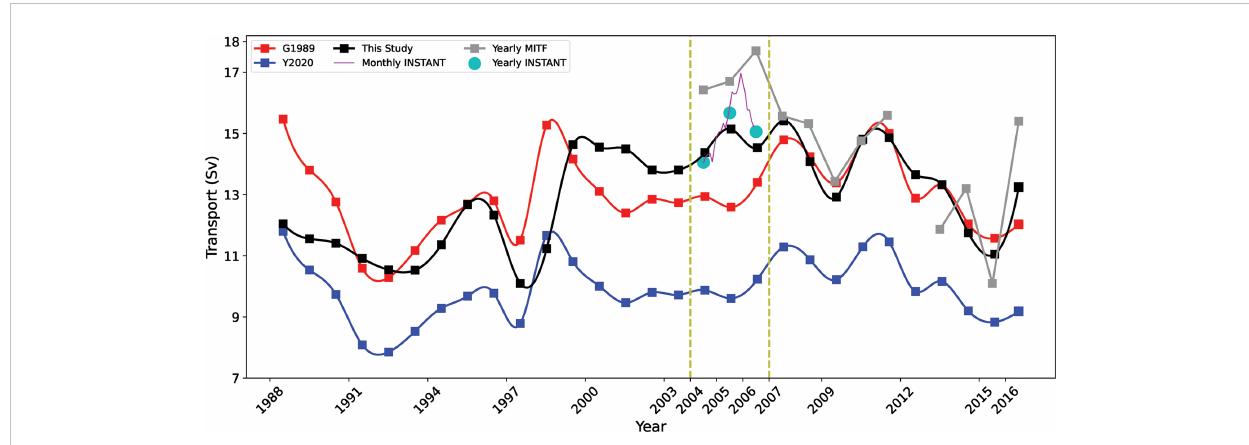
FIGURE 9 Yearly ITF transport during 1988-2016 derived from G1989 (red), Y2020 (blue) and the solution of this study (black). Yearly and monthly INSTANT observations during 2004-2006 (cyan and magenta respectively) and yearly MITF transport during 2004-2016 (gray) are also shown for